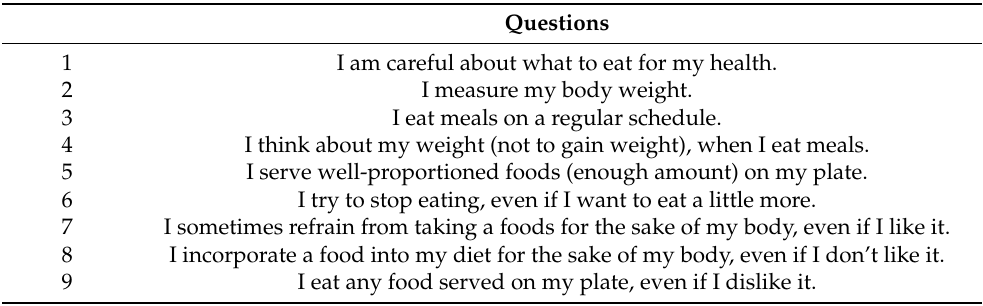
Table 2. Eating behavior